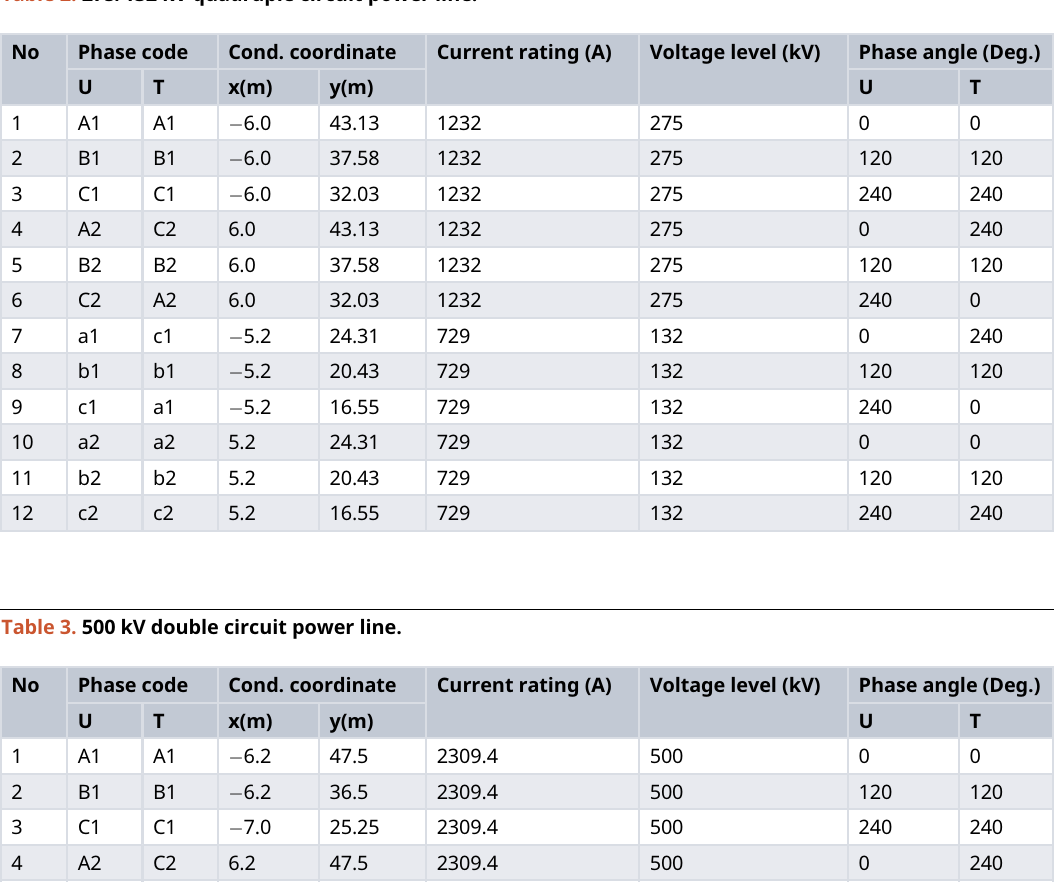
Table 2. 275/132 kV quadruple circuit power